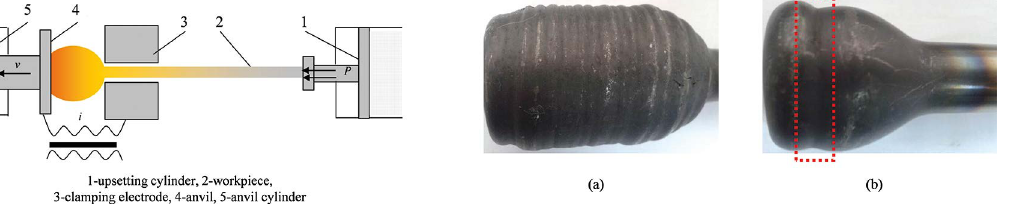
Figure 2: Schematic drawing of electric upsetting process. QForm, MSC.Marc, Ansys, etc. are available in numerical simulation of electric upsetting process.